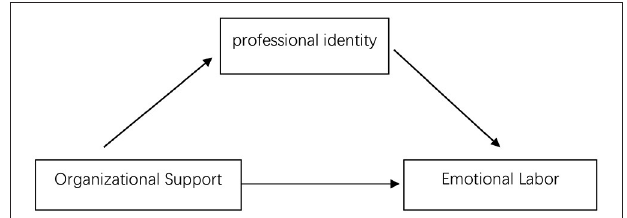
FIGURE 1 | Theoretical model of this